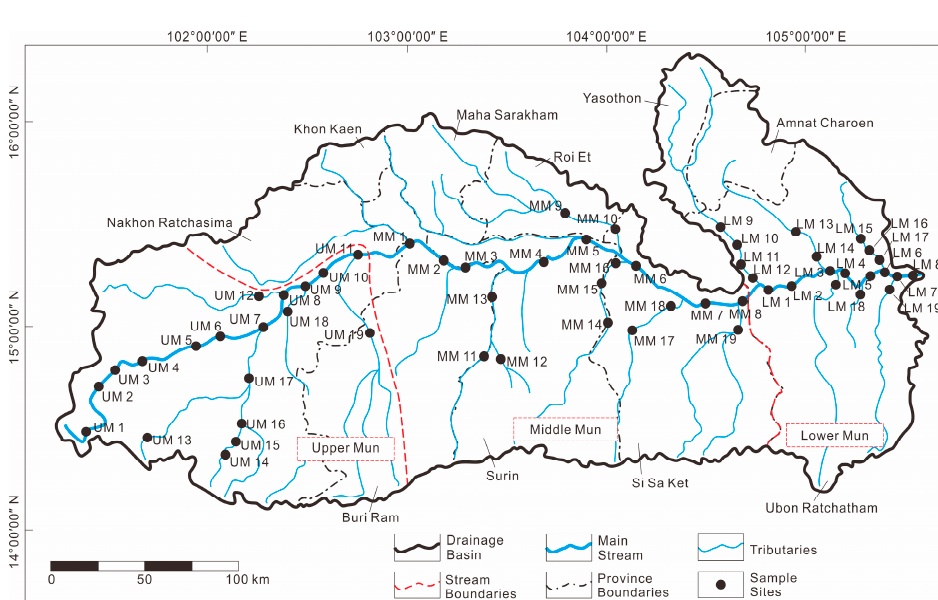
Figure 2. Sample distribution in the Mun River.